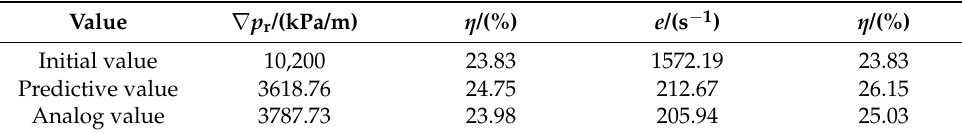
Table 6. Comparison of optimization results ( ∇ p r - η and e - η